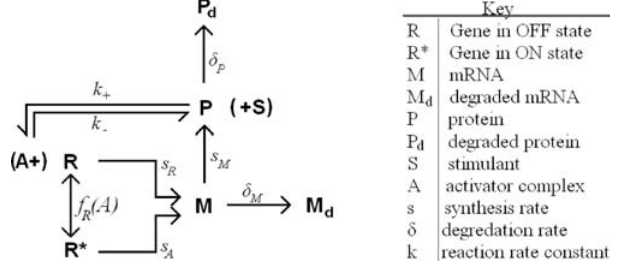
Figure 2. Reaction scheme for the feedback system. Each node corresponds to a reaction governed by a transition propensity, with lines and arrows representing reactants and products, respectively. A dotted line signifies that the ‘reactant’ is not consumed.